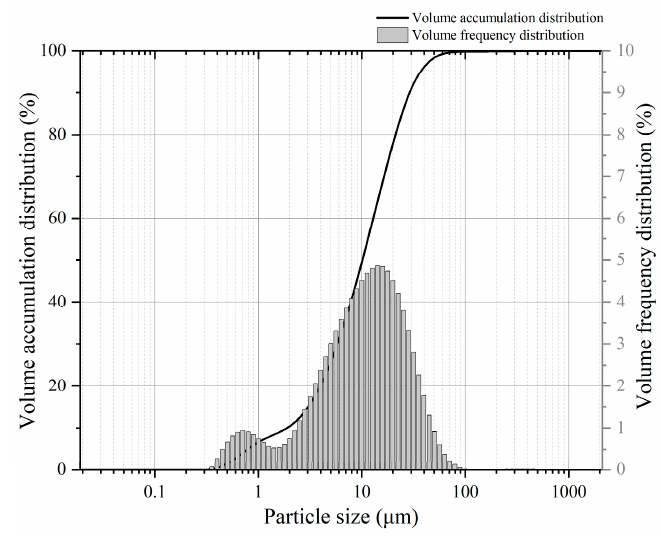
Figure 3. Particle size distribution of fly ash.